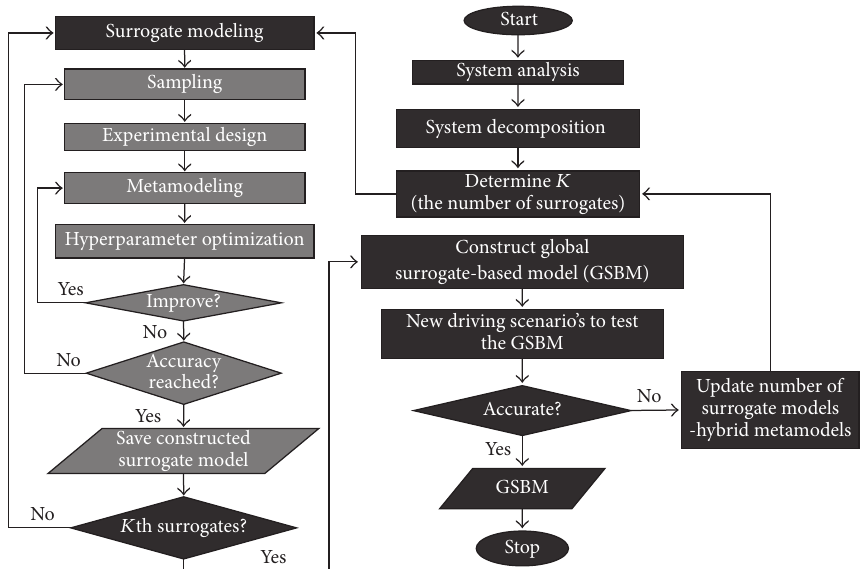
Figure 2: Flowchart of developing a global surrogate-based model